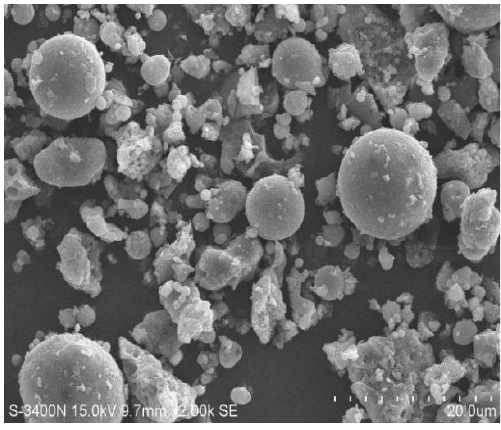
Figure 13. SEM images of fly